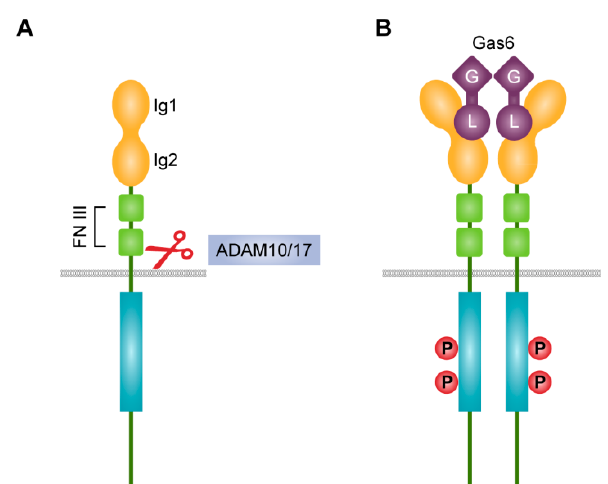
Figure 1. Structure and activation of Axl receptor. ( A ) The ectodomain of Axl consists of the N-terminal immunoglobulin-like Ig (Ig1, Ig2) and two fibronectin (FN) type III domains. ADAM10 and ADAM17 can cleave the ectodomain between valine 438 and tryptophan 452 (V438-W452) close to the transmembrane region. Red scissors indicate proteolytic cleavage. ( B ) Gas6/Axl homo-dimerizes in a 1:1 stoichiometry resulting in the tyrosine phosphorylation of ICDs. Gas6 binds to the Ig domains of Axl by the carboxy-terminal laminin G-like domain (L). The amino-terminal Gla domain of Gas6 (G) binds to the lipid phosphatidylserine.